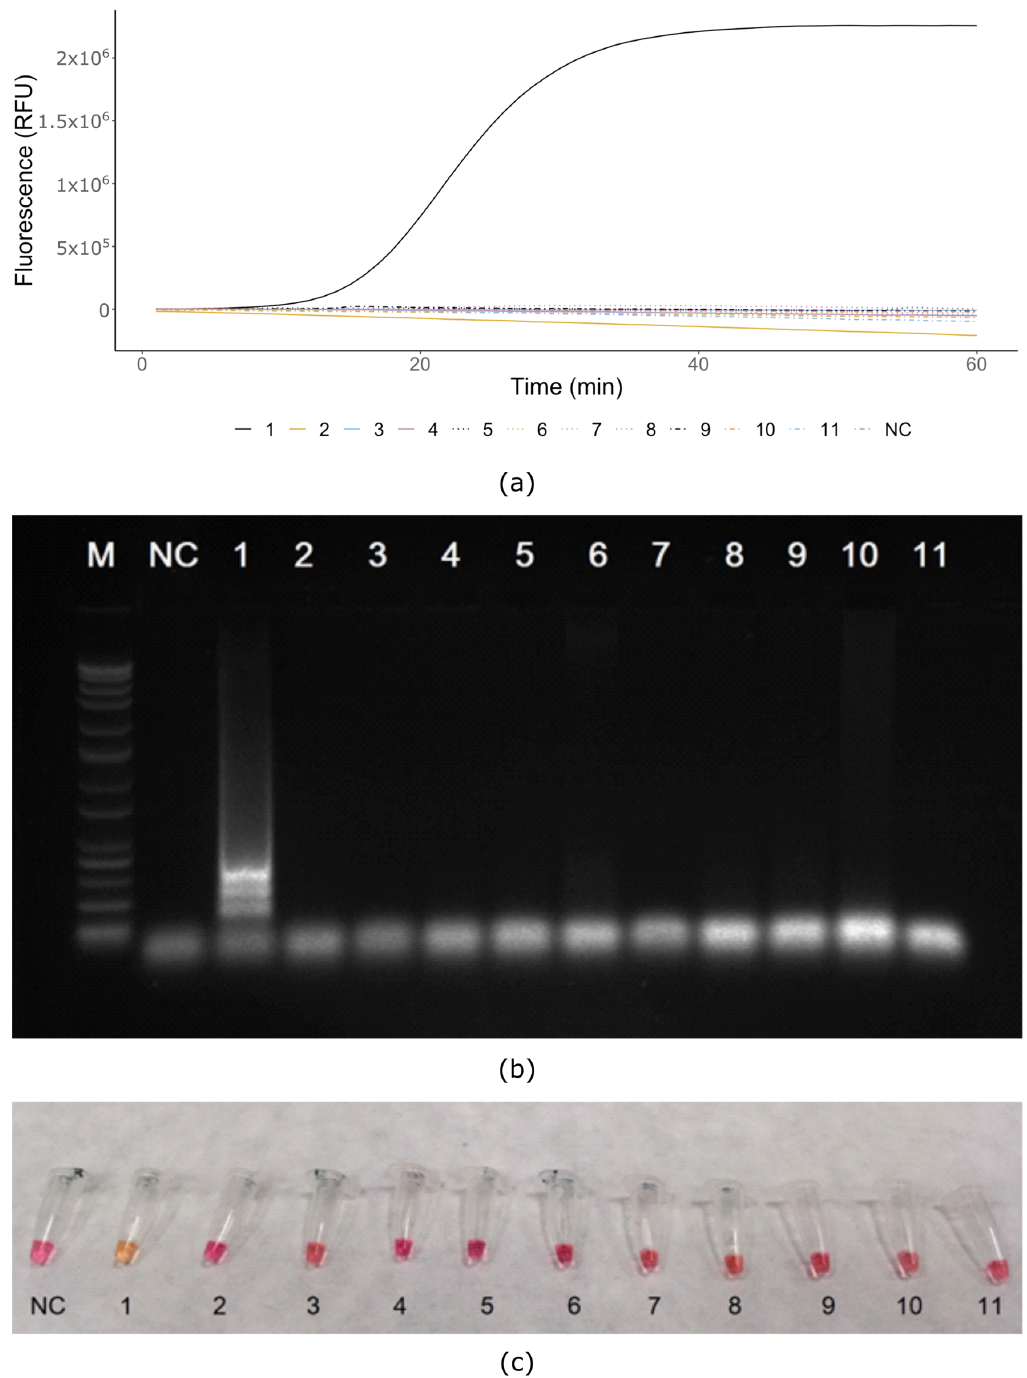
Figure 1. Specificity of selected bacterial species: ( a ) real-time LAMP assay (QuantStudio™ 6 Flex Real-Time PCR System); ( b ) gel electrophoresis of LAMP products confirms results of real-time LAMP; ( c ) Colorimetric Master Mix assay after 30 min reaction time; M—ladder 100 bp (NEB, Hitchin,